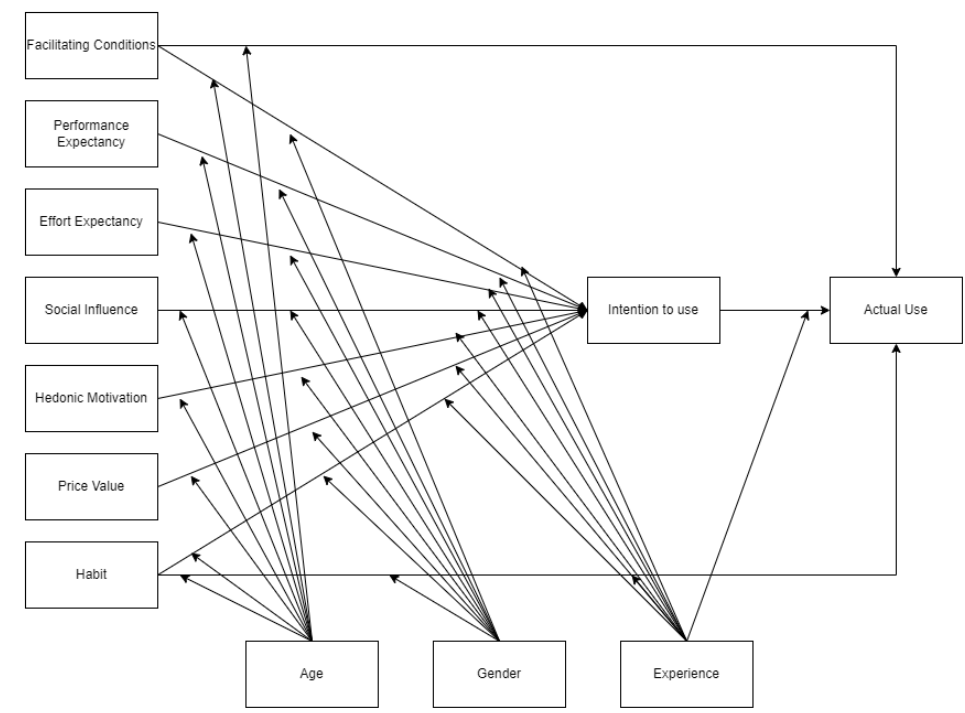
Figure 1. The original UTAUT-2 model with moderator variable.